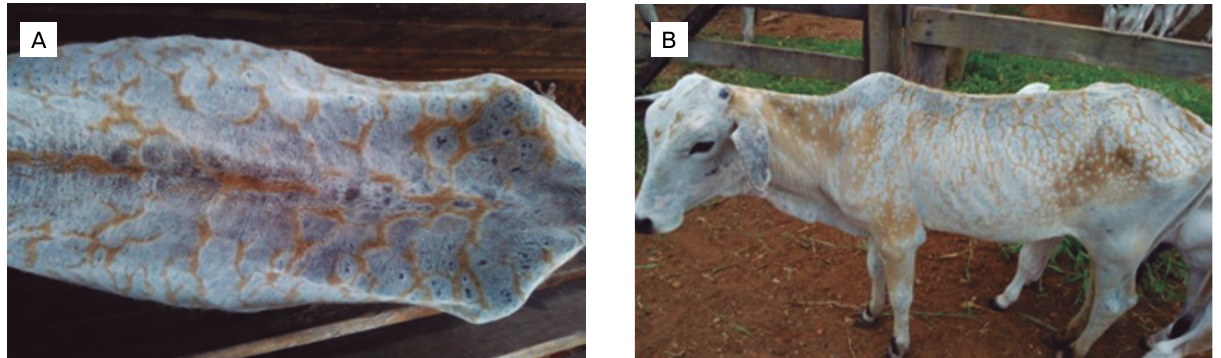
Figure 2. Microbiological diagnosis of bovine dermatophilosis. (A) Rough, hemolytic, dry, golden-yellow colonies of 1 mm in diameter of Dermatophilus congolensis isolated in defibrinated sheep blood agar at aerobic and 5% CO of incubation. (B) Gram-positive branching organisms or “tram-track” appearance of Dermatophilus congolensis (Gram staining, 1,000 x). Botucatu, SP, Brazil, 2014.